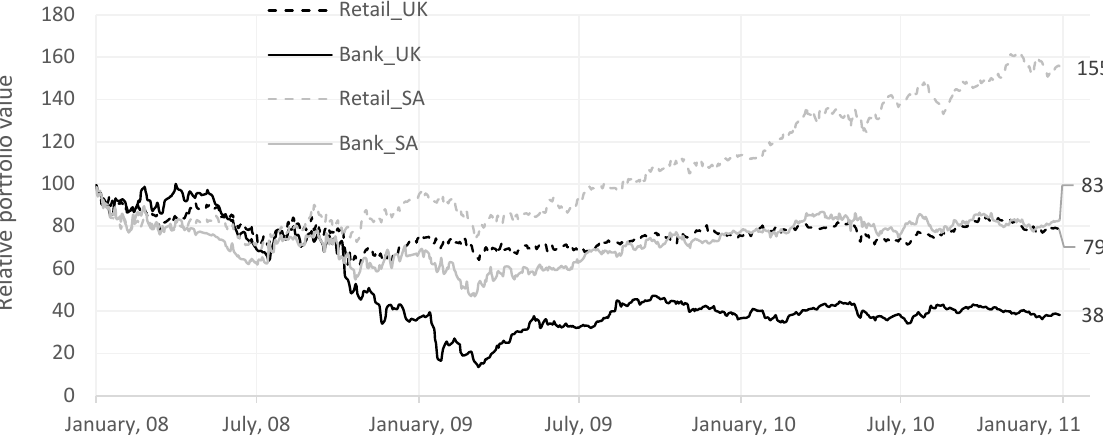
Figure 6. Relative portfolio development from 2008 to